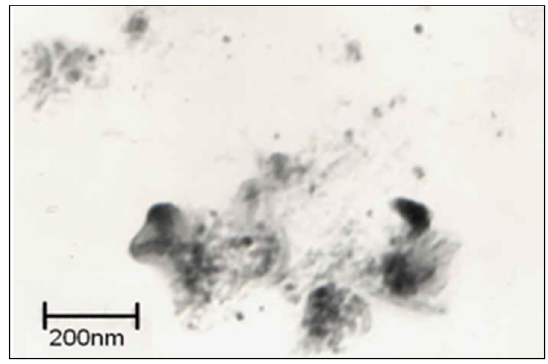
Figure 6. TEM pattern of the 5%Co-M